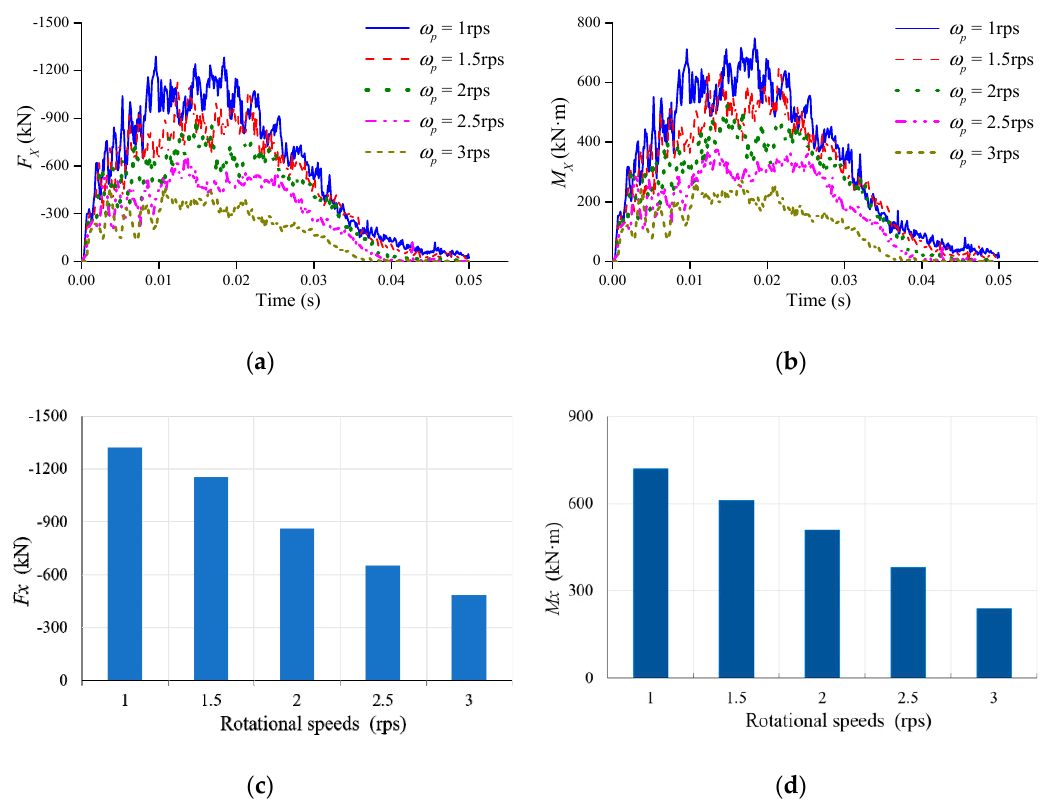
Figure 14. Time series of ice load Fx and Mx based on simulations with different rotation speeds. ( a ) The Fx with different rotation speeds. ( b ) The Mx with different rotation speeds. ( c )The maximum Fx with different rotation speeds. ( d ) The maximum Mx with different rotation speeds.